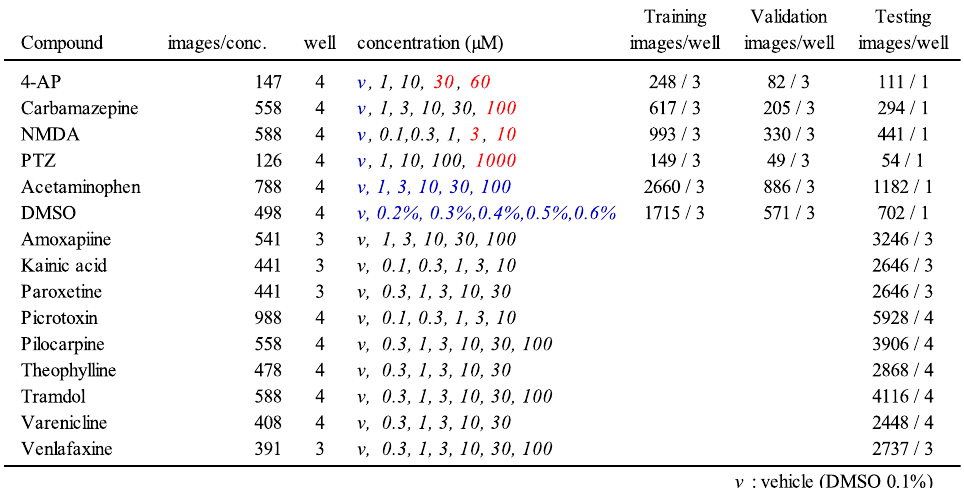
Table 1. Dataset information using creation of seizure risk prediction AI. The concentration in red letters indicates the concentration learned as seizure-causing, and blue letters indicate the concentration learned as